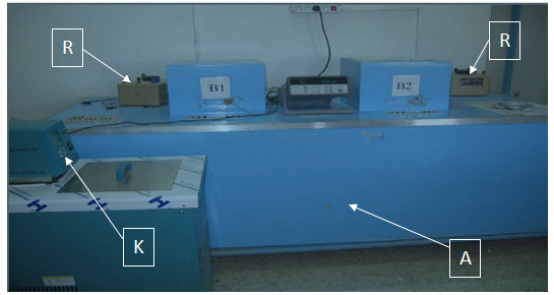
Figure 3. Measurement of the thermal conductivity